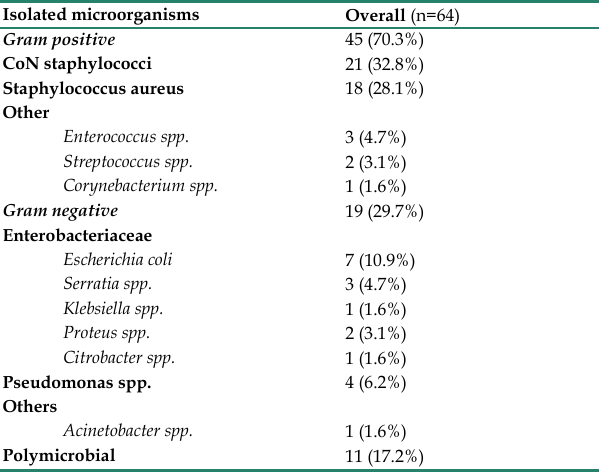
Table 1. Microorganisms isolated in 38 confirmed prosthetic joint infection cases Isolated microorganisms